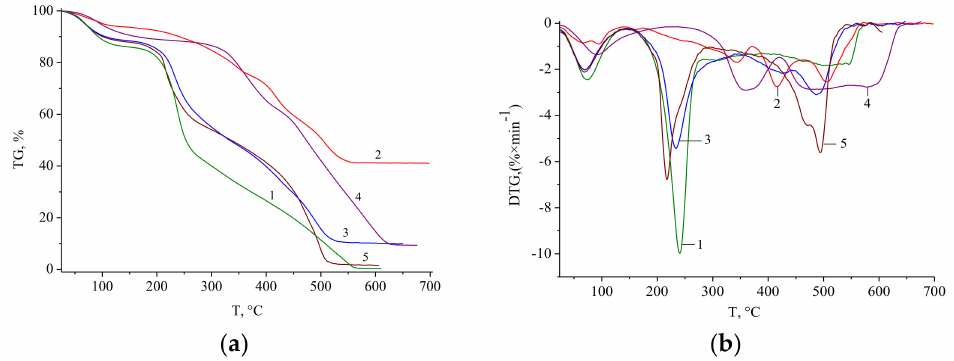
Figure 2. TG ( a ) and DTG ( b ) curves obtained for thermo-oxidative degradation of pure compounds- CS (line 1), CoPc (line 2), CuPc (line 4) and their complexes-CS-CoPc (line 3) and CS-CuPc (line 5) at a heating rate of 10 ◦ C · min − 1 in air. Table 1. Parameters of thermogravimetric measurements of dehydration processes and thermal oxidative degradation of CS, CoPc, CS-CoPc, CuPc, and CS-CuPc in air a . Stage Temperature